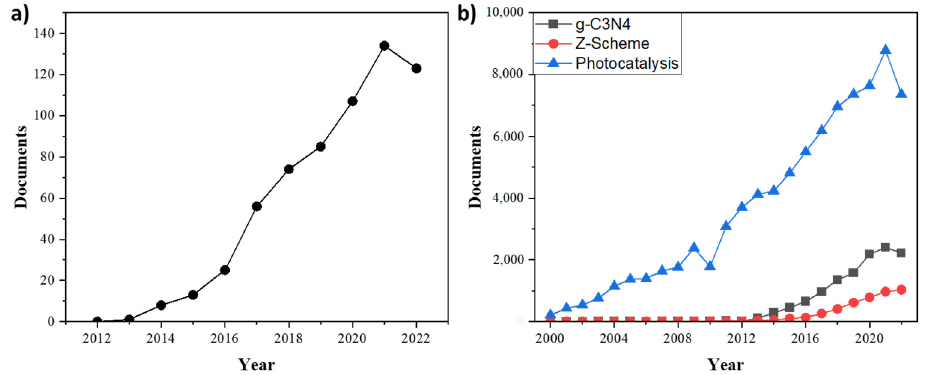
Figure 2. ( a ) Number of publications per year on g -C 3 N 4 -based Z-scheme photocatalysts